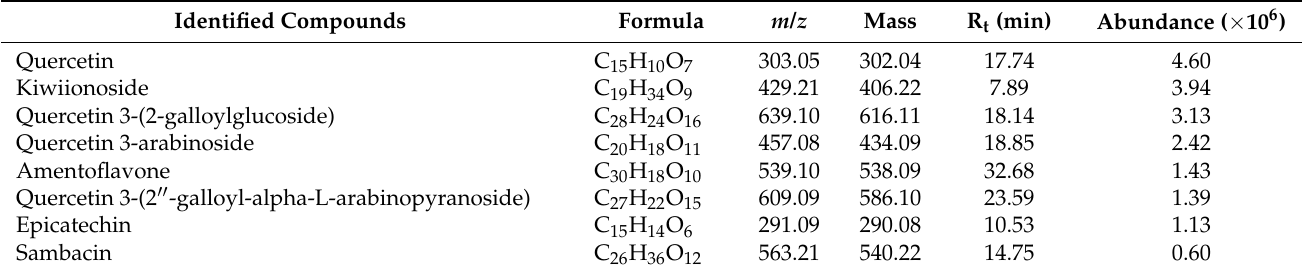
Table 6. Phenolic compounds in CLE extracted under optimized extracting condition analyzed by LC/DAD/MSD in positive